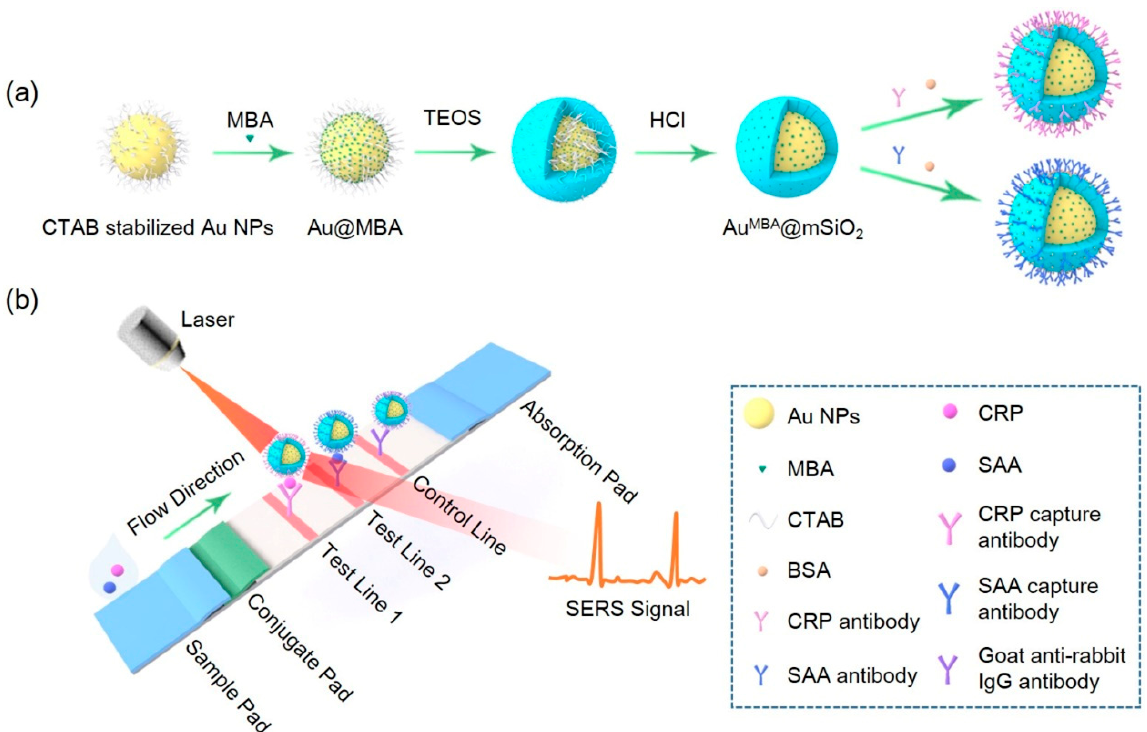
Figure 1. ( a ) The preparation flow chart of the core-shell Au MBA @mSiO 2 nanotags; ( b ) the principle of the SERS-LFA strip for detection of SAA and CRP.